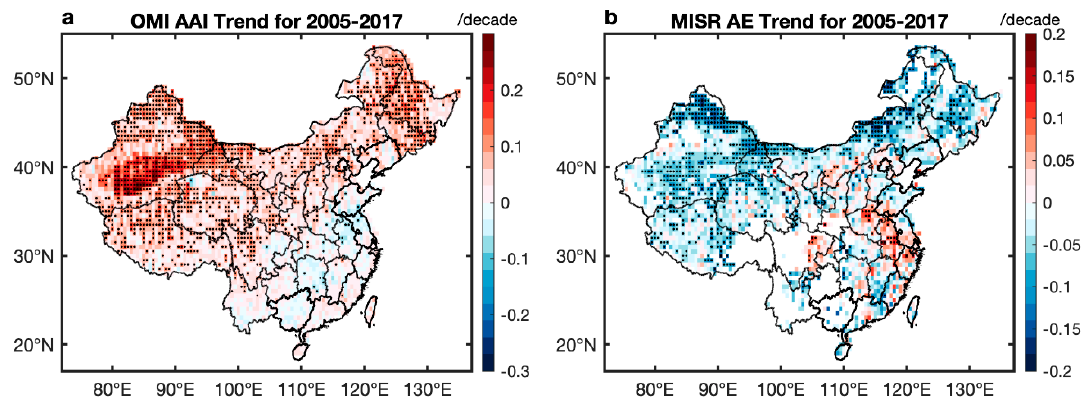
Figure 6. OMI AAI ( a ) and MISR AE ( b ) trends calculated for the 2005–2017 period. The trends were calculated as the Sen’s slope and tested using the Mann–Kendall test. Trends with significance level > 95% are marked with black dots. Remote Sens. 2020 , 12 , x FOR PEER REVIEW